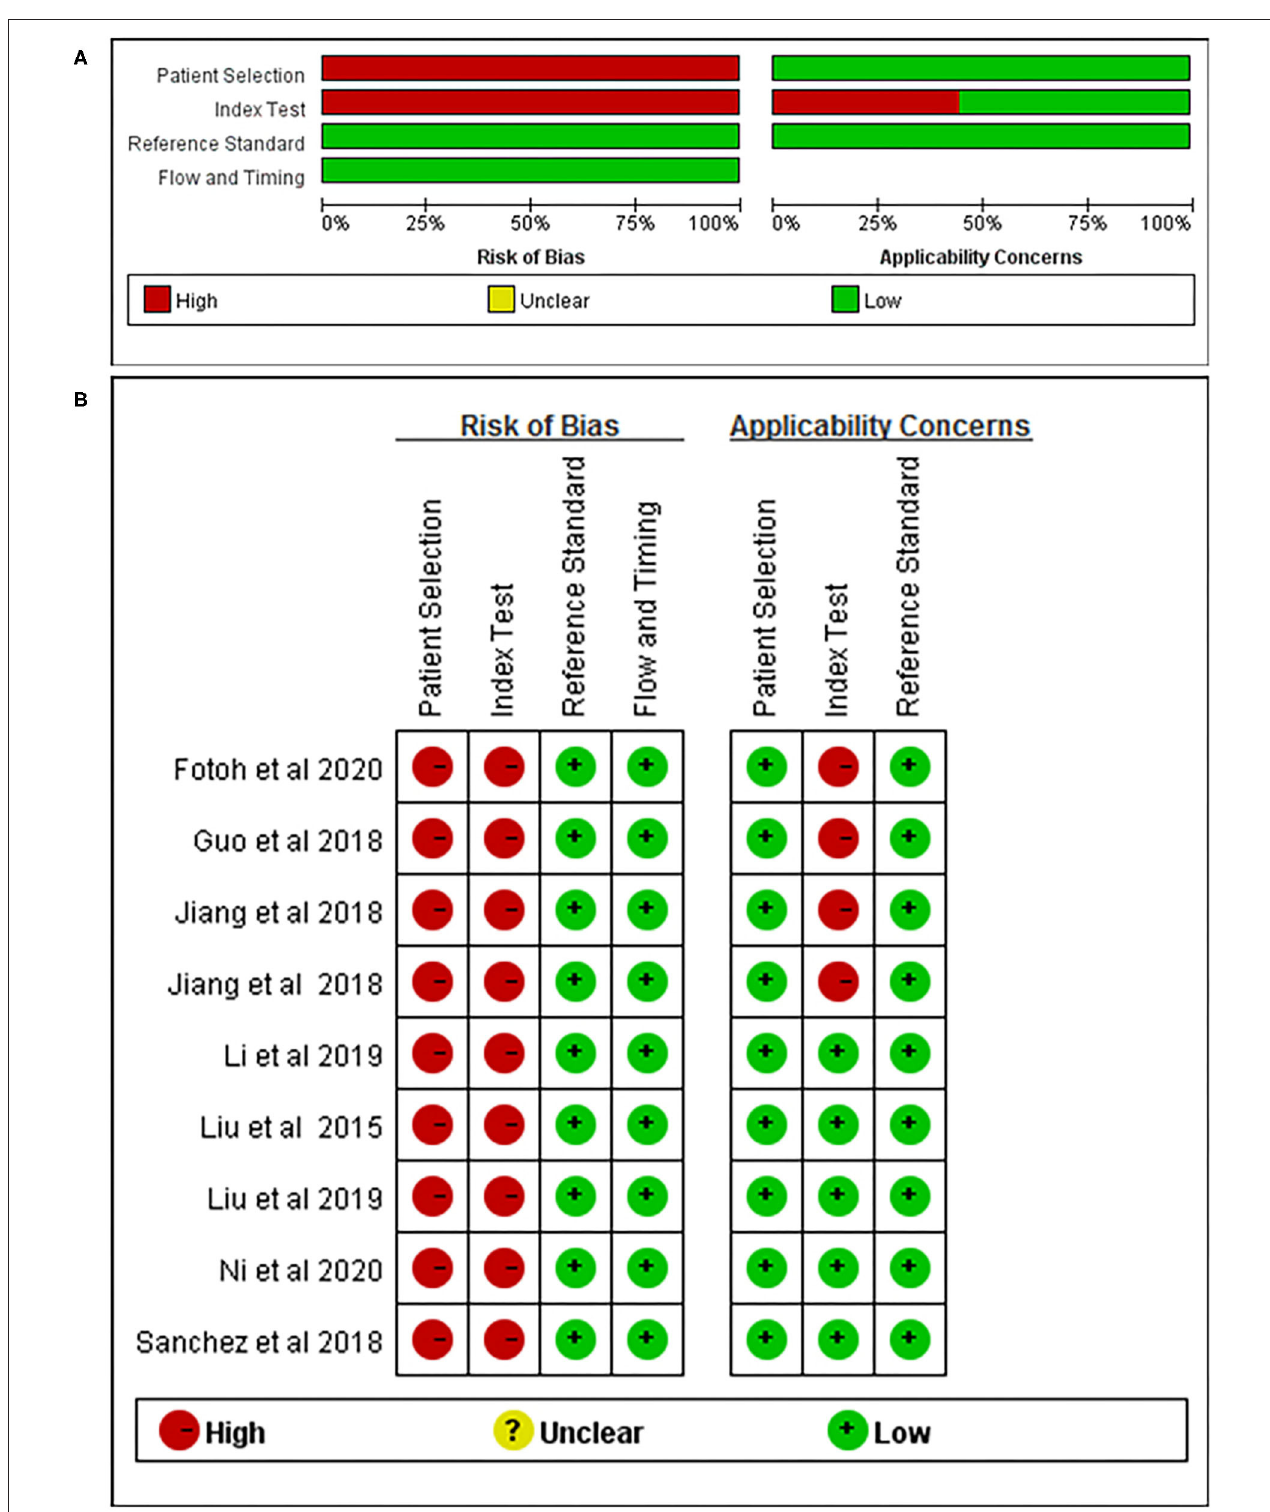
FIGURE 2 | QUADAS-2 assessment. Risk of bias and applicability concerns’ (A) graph and (B) summary.